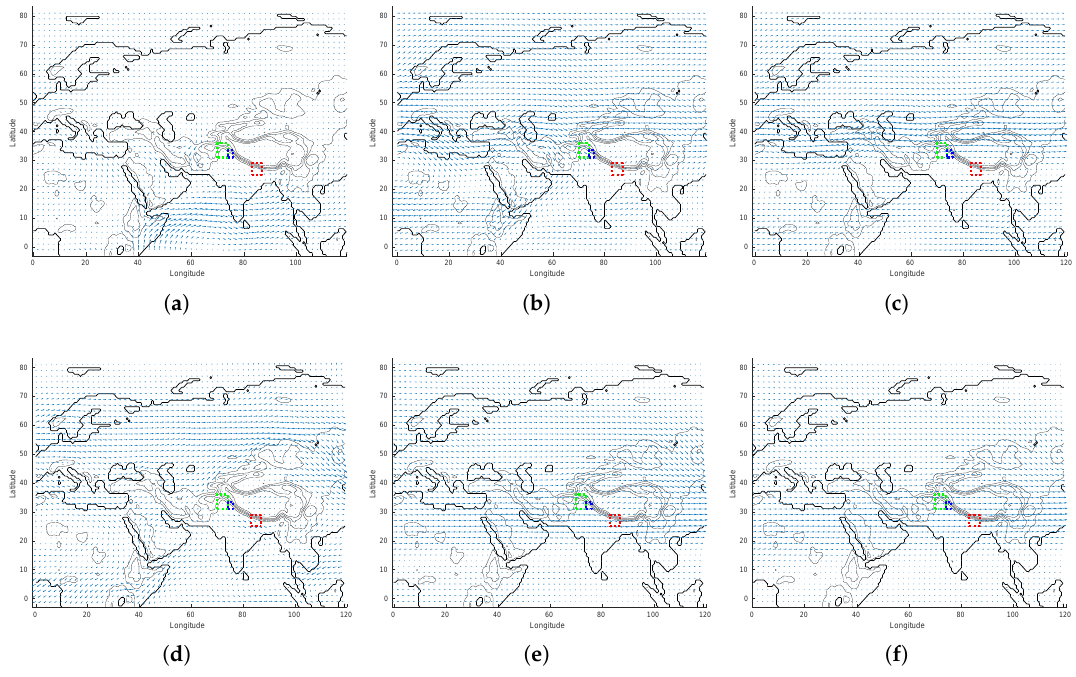
Figure 3. Figure showing the seasonal wind fields between 1980–2016 for: ( a ) 800 hPa level for JJA ( b ) 500 hPa level for JJA ( c ) 300 hPa level for JJA ( d ) 800 hPa level for NDJ ( e ) 500 hPa level for NDJ ( f ) 300 hPa level for NDJ. Green, blue and red boxes are NP , U and K regions,